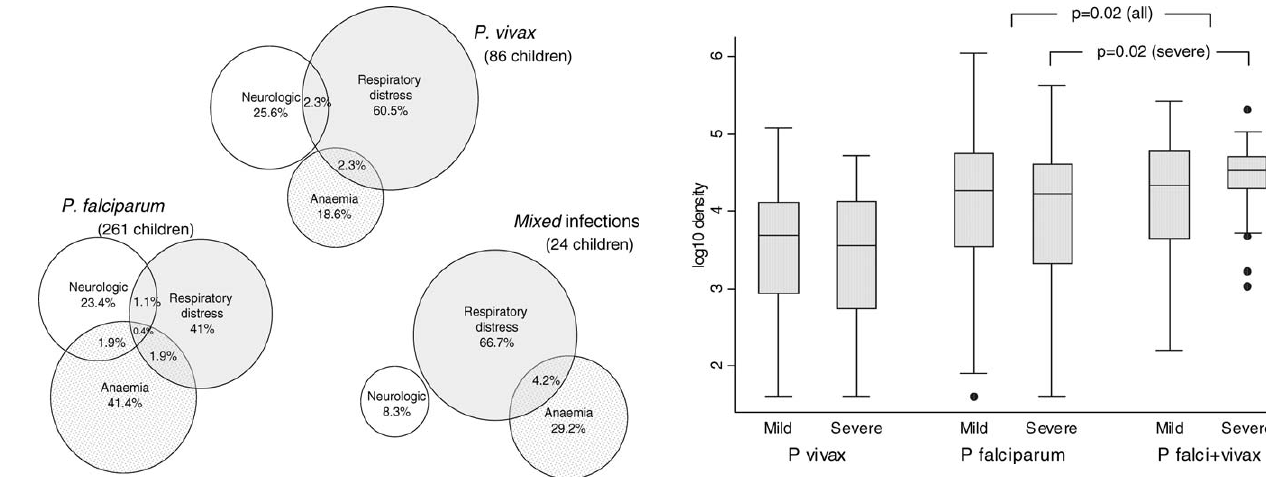
Figure 4. Proportion of SM Cases with Each of the Main Defining Clinical or Laboratory Features among Children , 5 y Infected with P. vivax , P. falciparum , and Mixed Species (Venn Diagram)